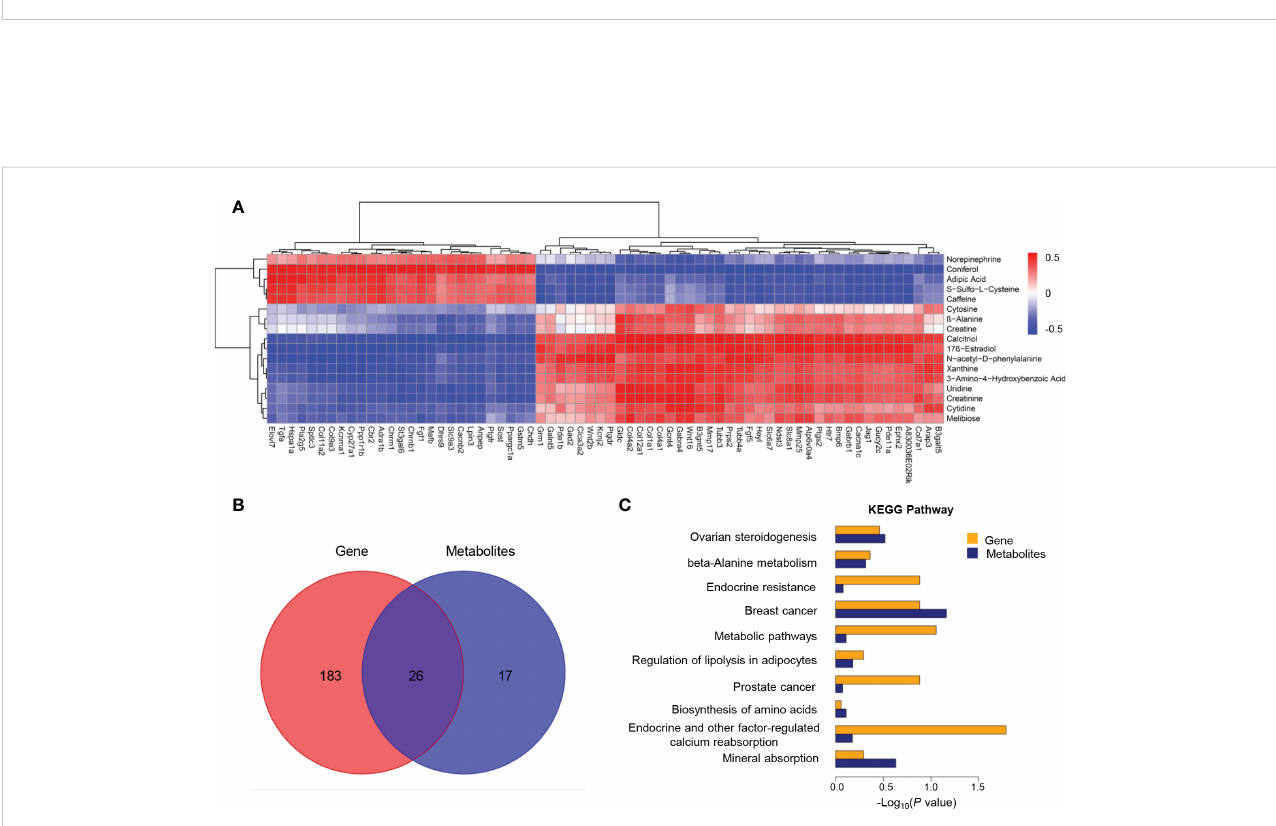
FIGURE 5 Co-analysis of mCOB transcriptomes and metabolomes. (A) Heat map showing the Spearman correlation hierarchical cluster analysis of DEGs and differential metabolites. Horizontal direction representing genes and the vertical axis showing metabolites; (B) Venn diagram illustrating the overlap of pathways associated with DEGs and metabolites; (C) The top 10 shared KEGG pathways. The horizontal length re fl ecting FDR value. Blue color for genes and orange for